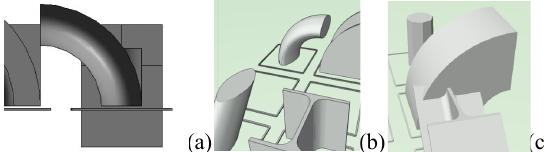
Figure 13. smooth surface in Revit (a) and Vectorworks